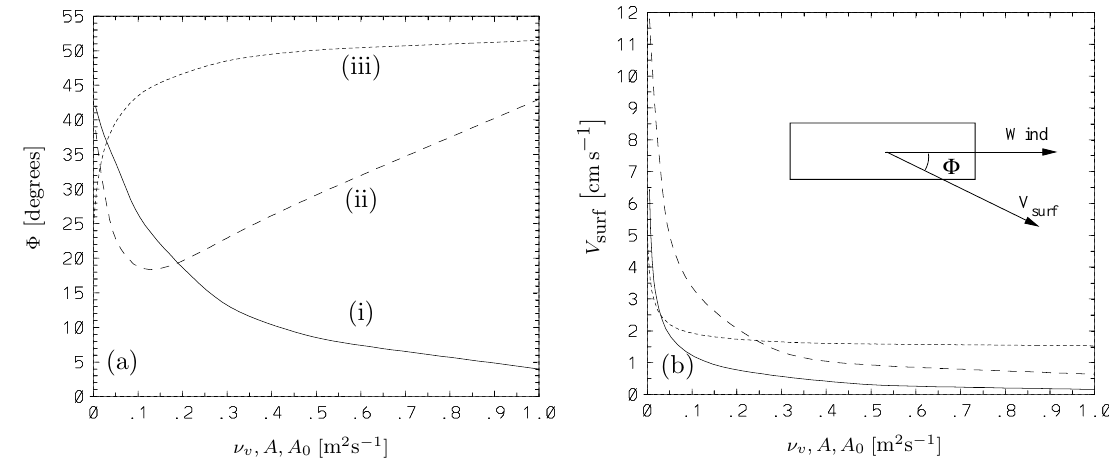
FIG. 1: Rotation angle Φ between wind and surface current (a) and absolute fluid velocity V Fig. 1. Rotation angle 8 between wind and surface current (a) and absolute fluid velocity V surf at the free surface (b) . Here 8 and V surf are free surface (b). Here Φ and V surf are plotted against ν v (solid curves), A (broken curves), A 0 (dotted plotted against ν v (solid curves), A (broken curves), A 0 (dotted curves), respectively, corresponding to the cases (i), (ii) and curves), respectively, corresponding to the cases (i), (ii) and (iii)